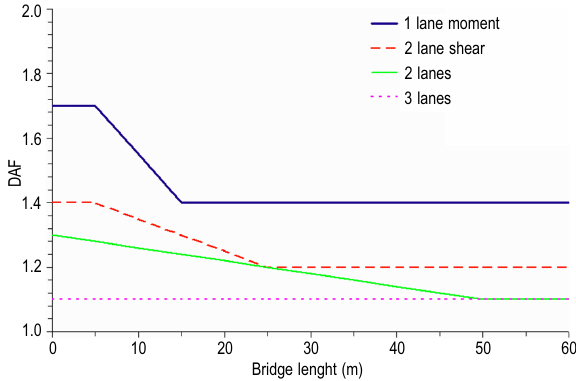
Fig. 3. DAF – dynamic amplification factor built-in values in the Eurocode 1 (Bruls et al. 1996)